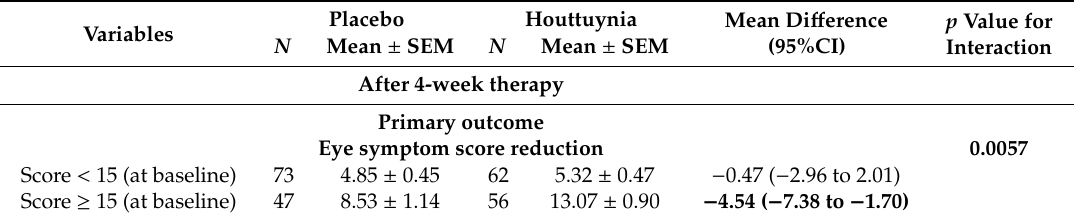
(Table 1). Patients were divided into four groups on the basis of meibum quality scores at baseline. Results show that the fall in the Houttuynia group was higher amongst each subgroup than in the placebo set ( p value for interaction = 0.0282) (Table 2). Values for TBUT in the Houttuynia